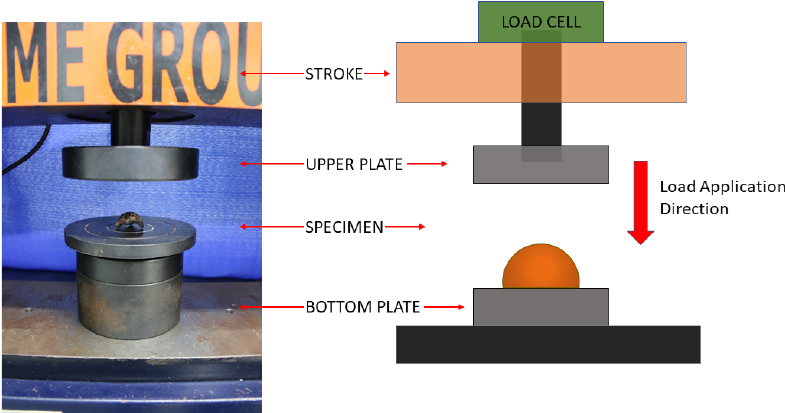
Figure 5. Crushed endocarp specimen during compressive strength test.